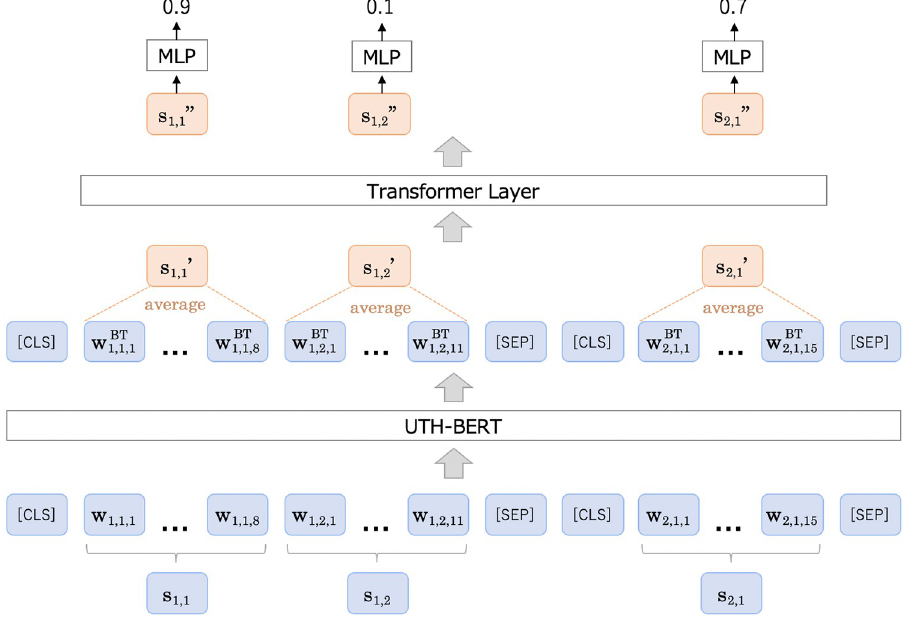
Fig 3. Overview of classification model for clinical